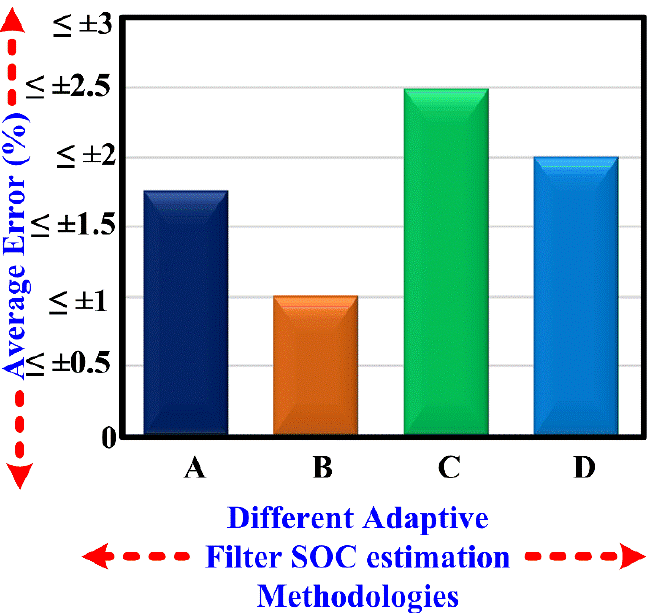
Figure 11. Comparison between the different adaptive filter SOC estimation methods. “A” is referred to as [75], “B” is referred to as [135], “C” is referred to as [91] and “D” is referred to as [136].